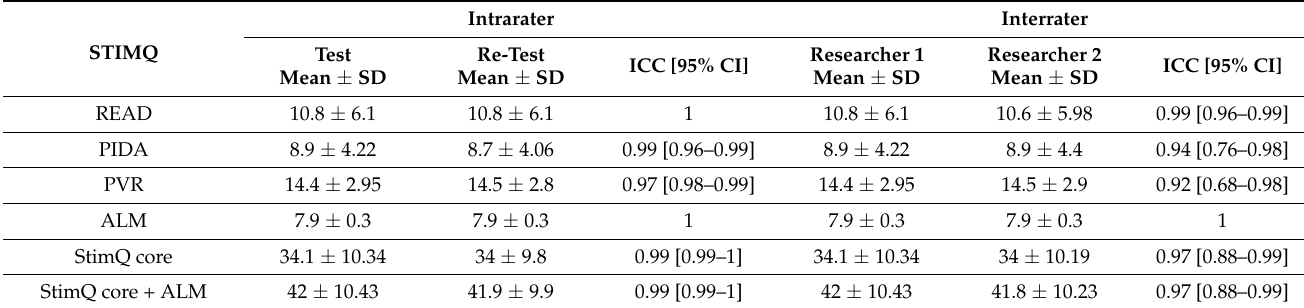
Table 7. Interrater and intrarater reliability scores for